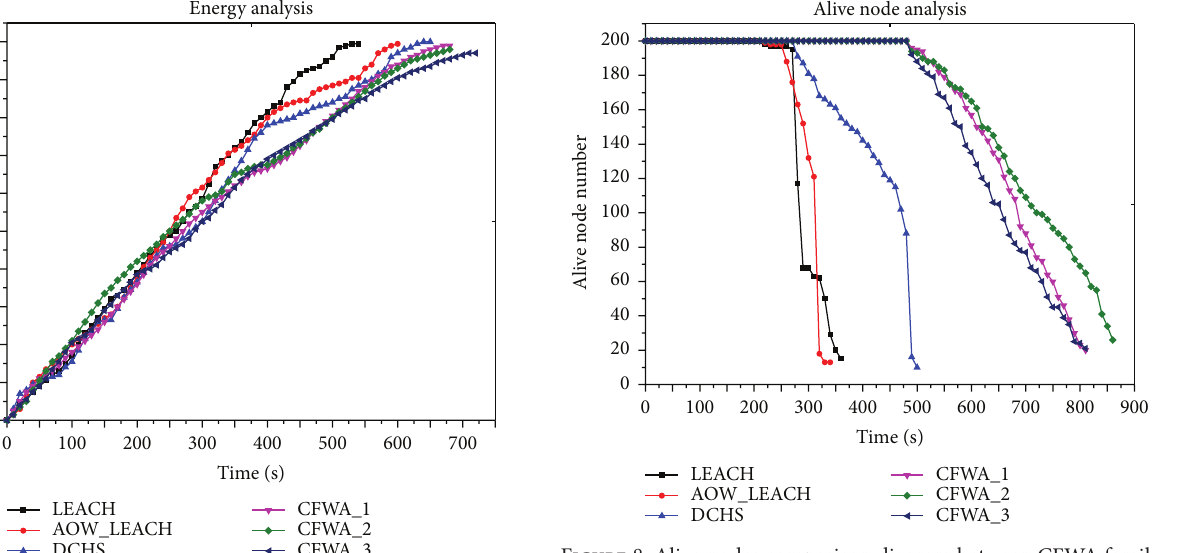
Figure 8: Alive nodes comparison diagram between CFWA family algorithms and LEACH-like algorithms in 200